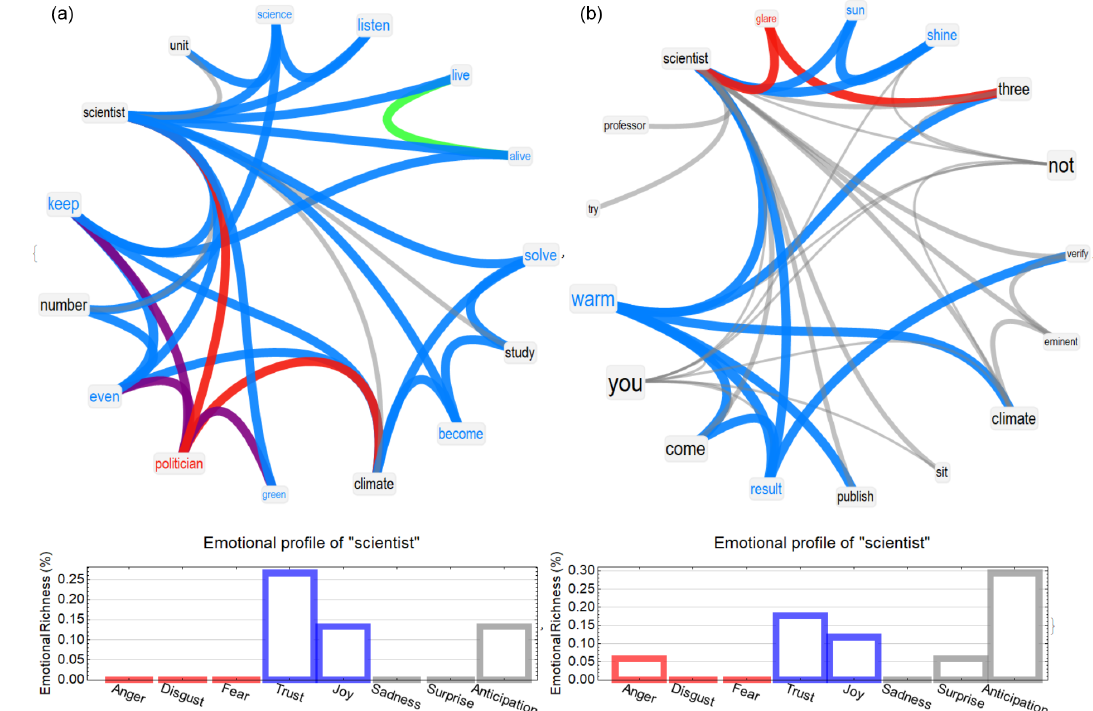
Figure 3. Speakers’ mindset reconstruction around “Scientist” in the speeches of Greta Thunberg (a) and Christopher Monckton (b) . We refer the reader to Fig. 1 for a detailed explanation of the colour code and to Lexicon 1 for an interpretation of the